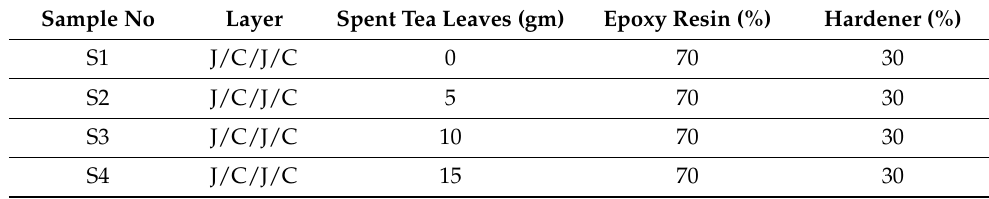
Table 3. Compositions of natural-element-based